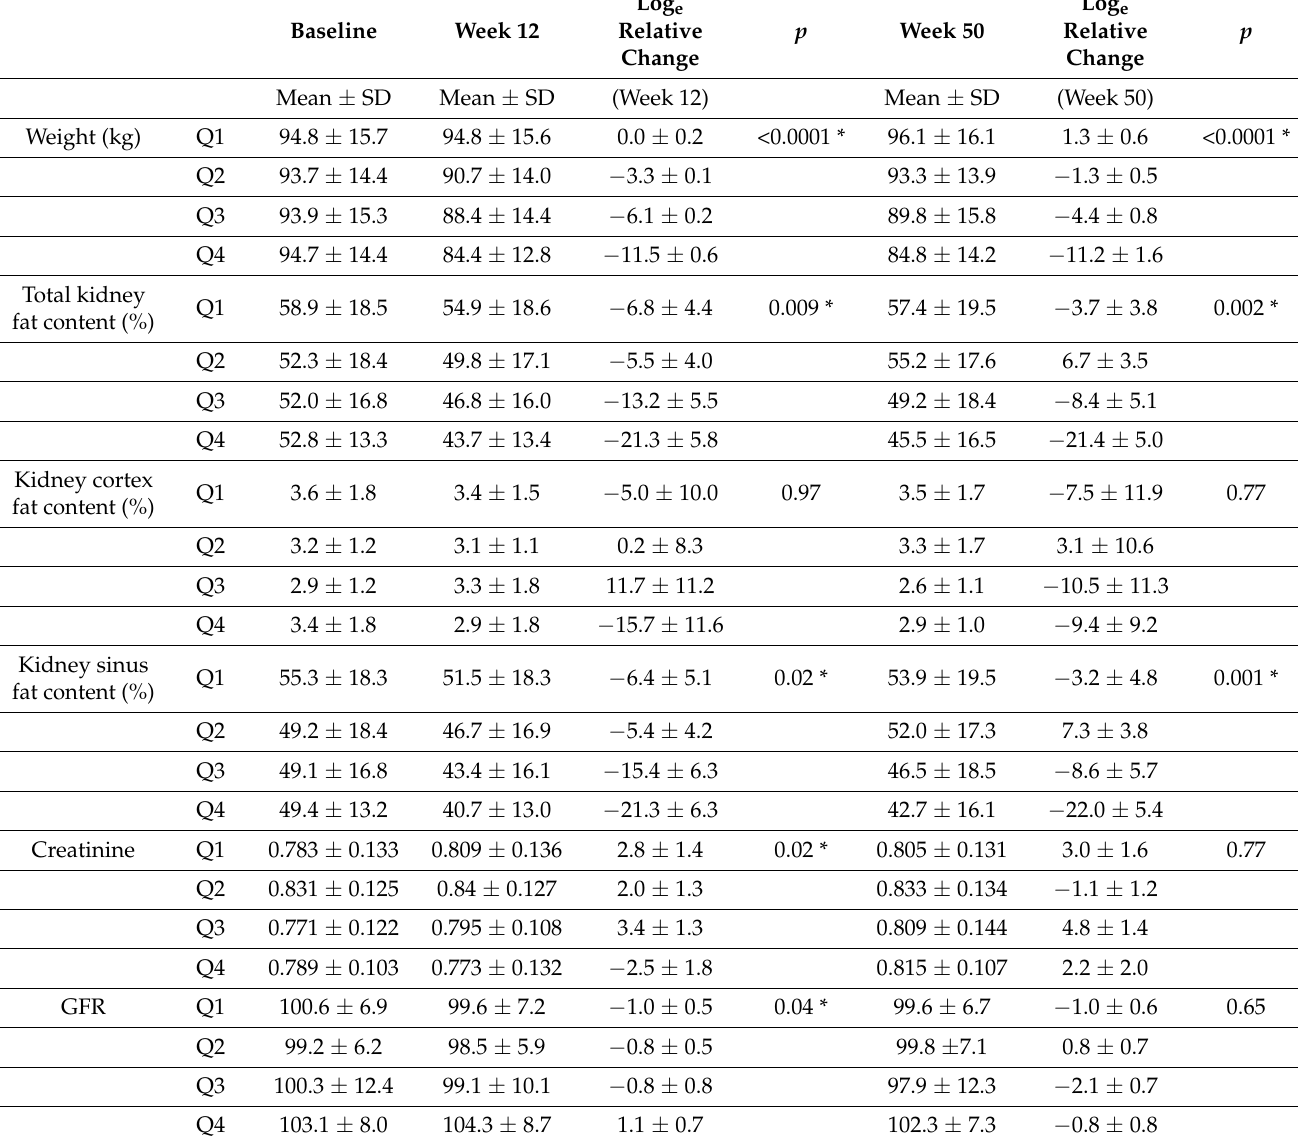
Table 3. Relative changes of body weight, total kidney fat content, renal cortex fat and sinus fat content, creatinine and glomerular filtration rate (GFR) from baseline to week 12 and from baseline to week 50; n =